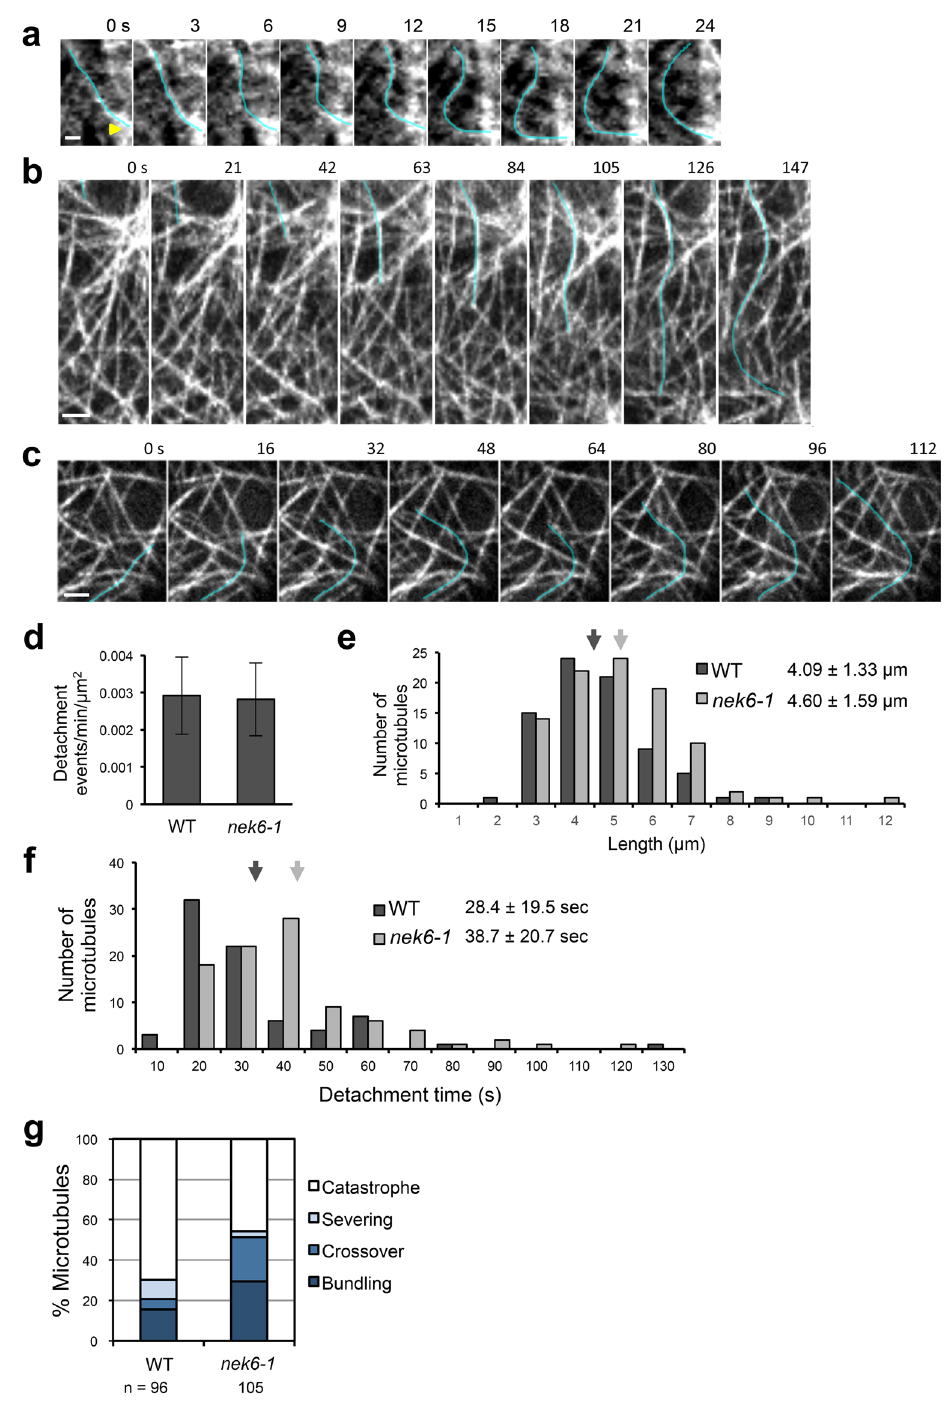
Figure 3. Distorted cortical microtubules in the nek6-1 mutant. ( a ) A time-lapse montage showing microtubule bending (blue line) near the site of microtubule crossover (arrow) in nek6-1 . The scale bar represents 1 µ m. ( b ) A time-lapse montage showing microtubule distortion (blue line) in a hypocotyl epidermal cell of nek6-1 . The scale bar represents 2 µ m. ( c ) A time-lapse montage showing microtubule distortion (blue line) in a cotyledon epidermal cell of nek6-1 . The scale bar represents 2 µ m. ( d ) Frequency of cortical microtubule detachments in cotyledon epidermal cells of the wild type and nek6-1 . Data are displayed as averages ± SD. ( e ) Length of detached and distorted cortical microtubules in cotyledon epidermal cells of the wild type and nek6-1 . Data are displayed as averages ± SD. Arrows indicate means that are significantly different ( t -test, P < 0.03). ( f ) Detachment times of cortical microtubules in cotyledon epidermal cells of the wild type and nek6-1 . Data are displayed as averages ± SD. Arrows indicate means that are significantly different ( t -test, P < 0.002). ( g ) The fate of detached microtubules in the wild type and nek6-1 . Microtubules were classified into four categories according to their behaviors after detachment from the cortex: catastrophe, severing, crossover, and